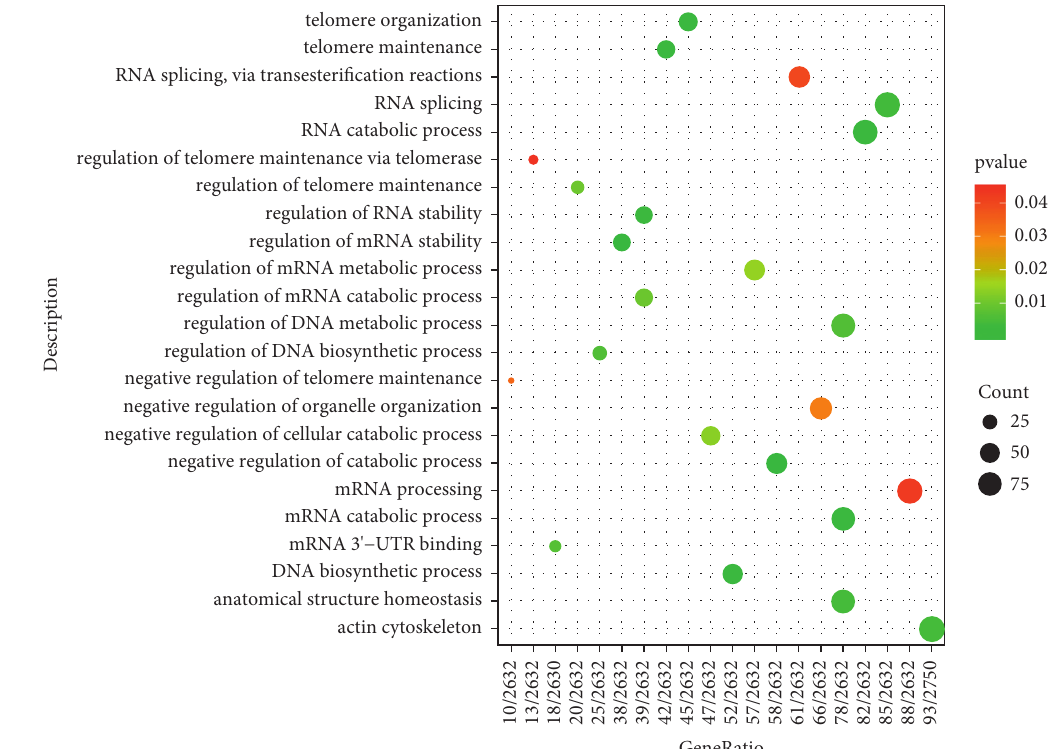
Figure 3: GO analysis involving HNRNPC . The more the genes in each enrichment item, the larger the bubble, and the P value from high to low corresponds to the color from red to green.